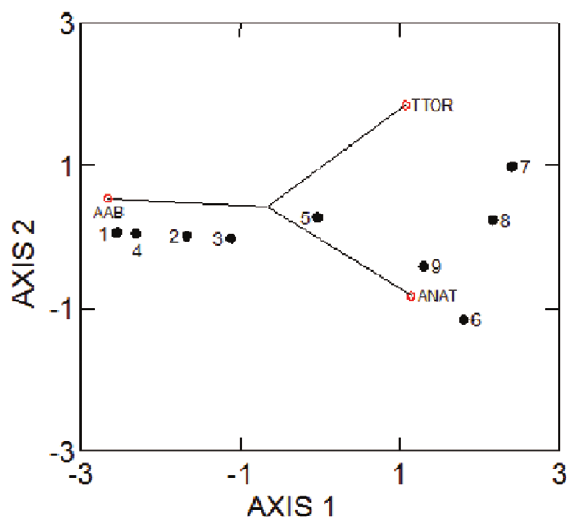
Fig. 4 - Biplot of Squamata species x studied areas of restinga ecosystems on the coast of the State of Bahia, Brazil, using three lizards species, Ameivula abaetensis (AAB), Ameivula nativo (ANAT) and Tropidurus torquatus (TTOR) as correspondence analysis factors: 1 = Costa Azul; 2 = Baixio; 3 = Guarajuba; 4 = Abaeté; 5 = Guaibim; 6 = Boipeba; 7 = Cassange; 8 = Taipe; 9 = Nova Viçosa.